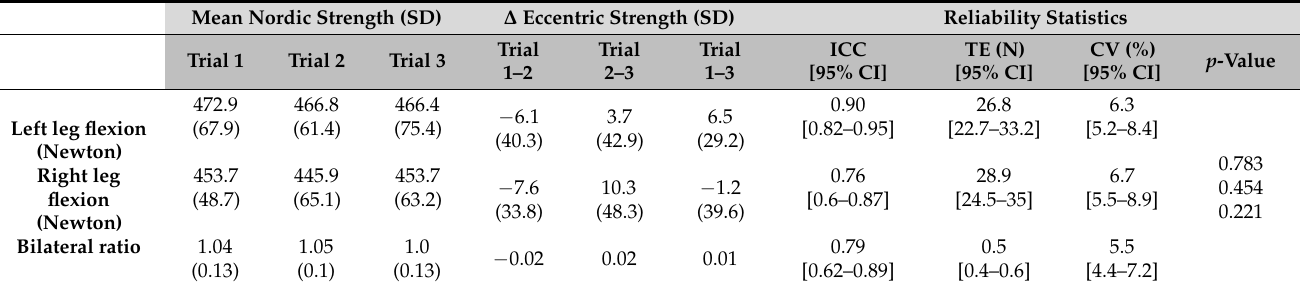
Table 1. Descriptive and reliability statistics related to intrasession isometric neck strength values. Values include mean, standard deviation, and 95% confidence intervals (upper, lower) for left leg, right leg, and balance examined. p -value from repeated measures analysis of variance. CI: confidence interval, CV: coefficient of variation, ICC: intraclass correlation coefficient, SD: standard deviation,